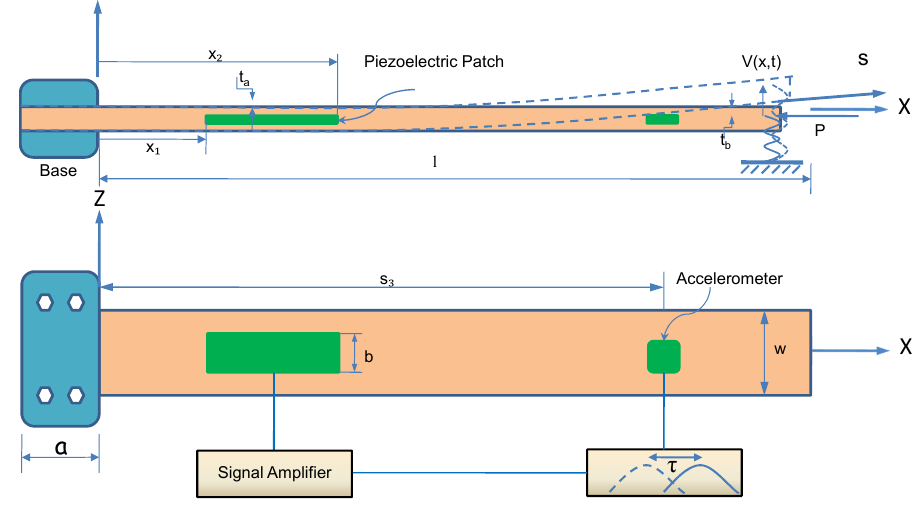
Figure 1. The theory model of the controlled beams.